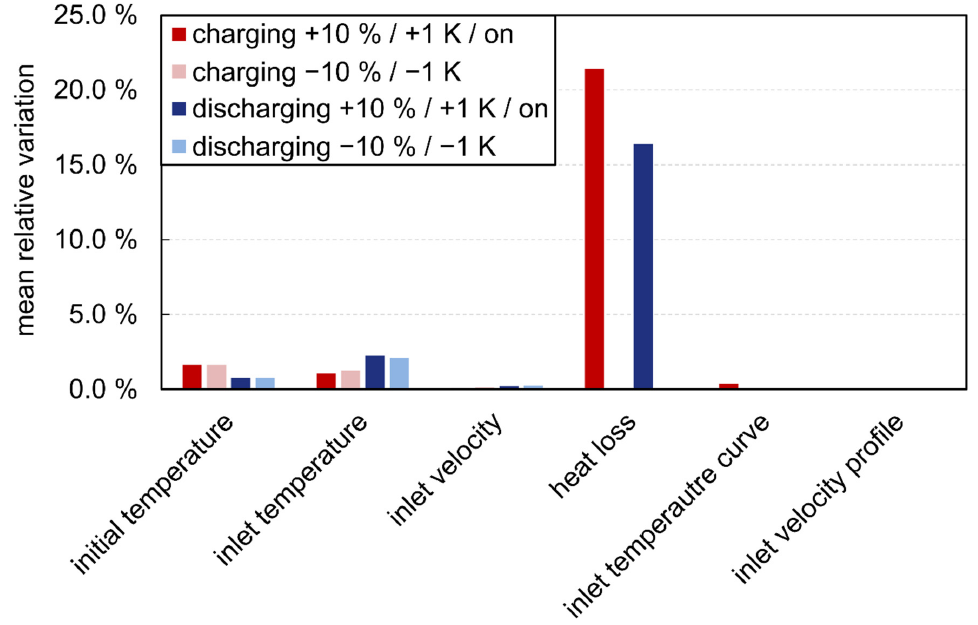
Figure 11. Absolute relative variation of the mean power for charging and discharging when varying the boundary and initial conditions.